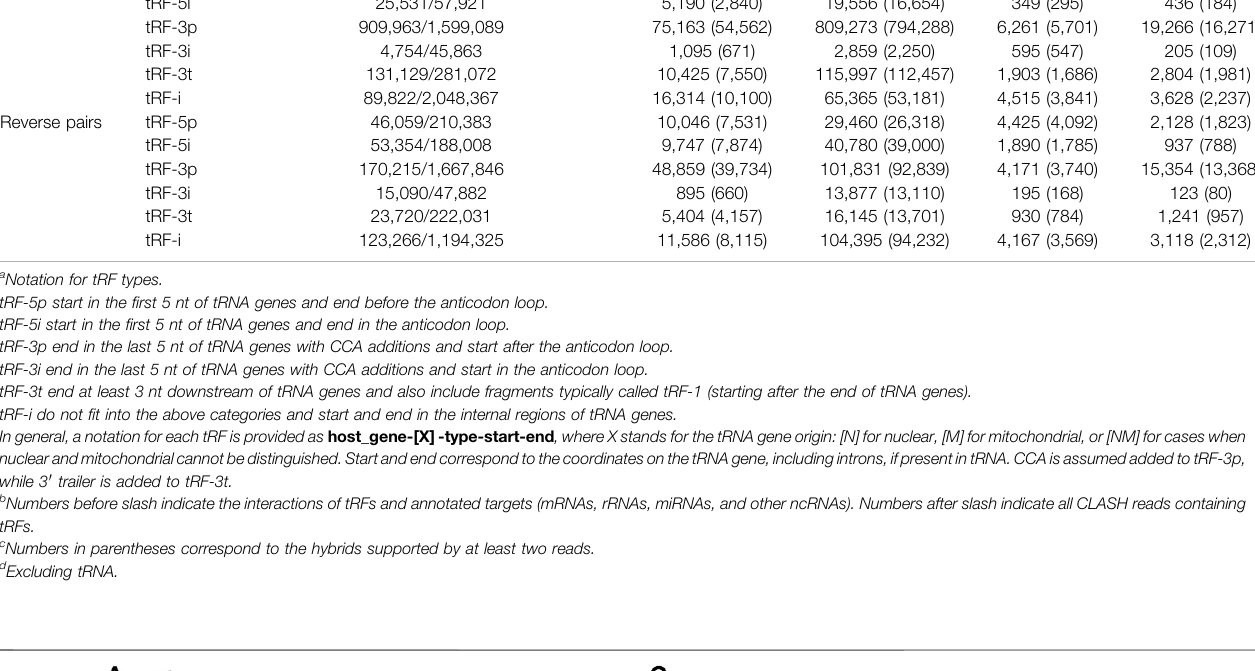
TABLE 1 | Numbers of reads supporting hybrids with speci fi c types of targets in forward and reverse pairs of tRFs. Guides a All aligned reads b ( < 80% match with tRNA) mRNA c rRNA miRNA Forward pairs